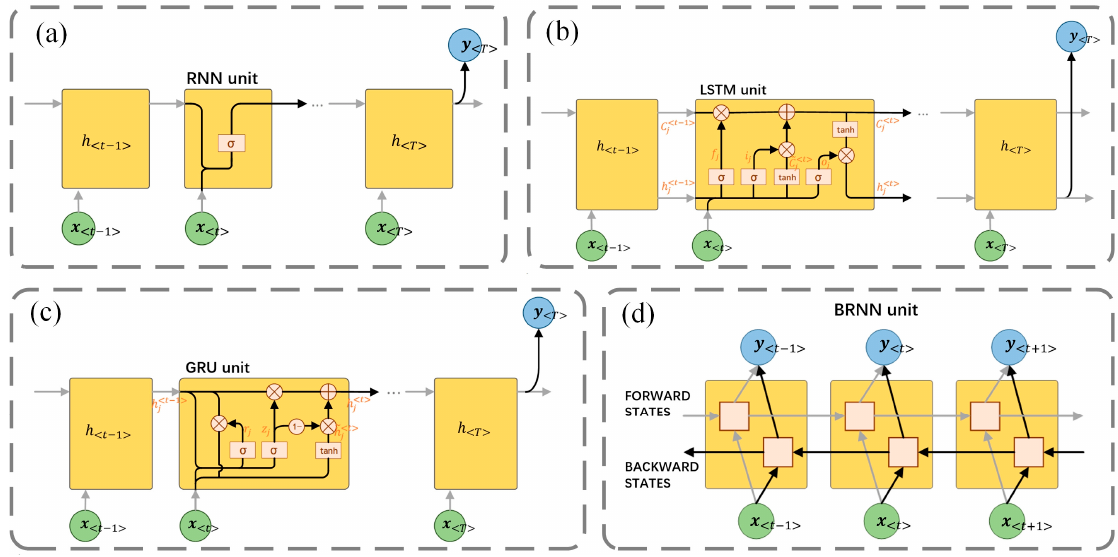
Figure 2. Structures of different RNNs: ( a ) structural of the RNN unit; ( b ) structure of the LSTM unit; ( c ) structure of the GRU unit; ( d ) structure of the BRNN unit.